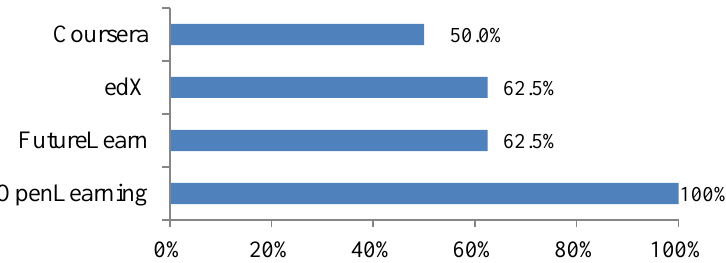
Figure 6 Proportion of courses with presence of instructors in discussion